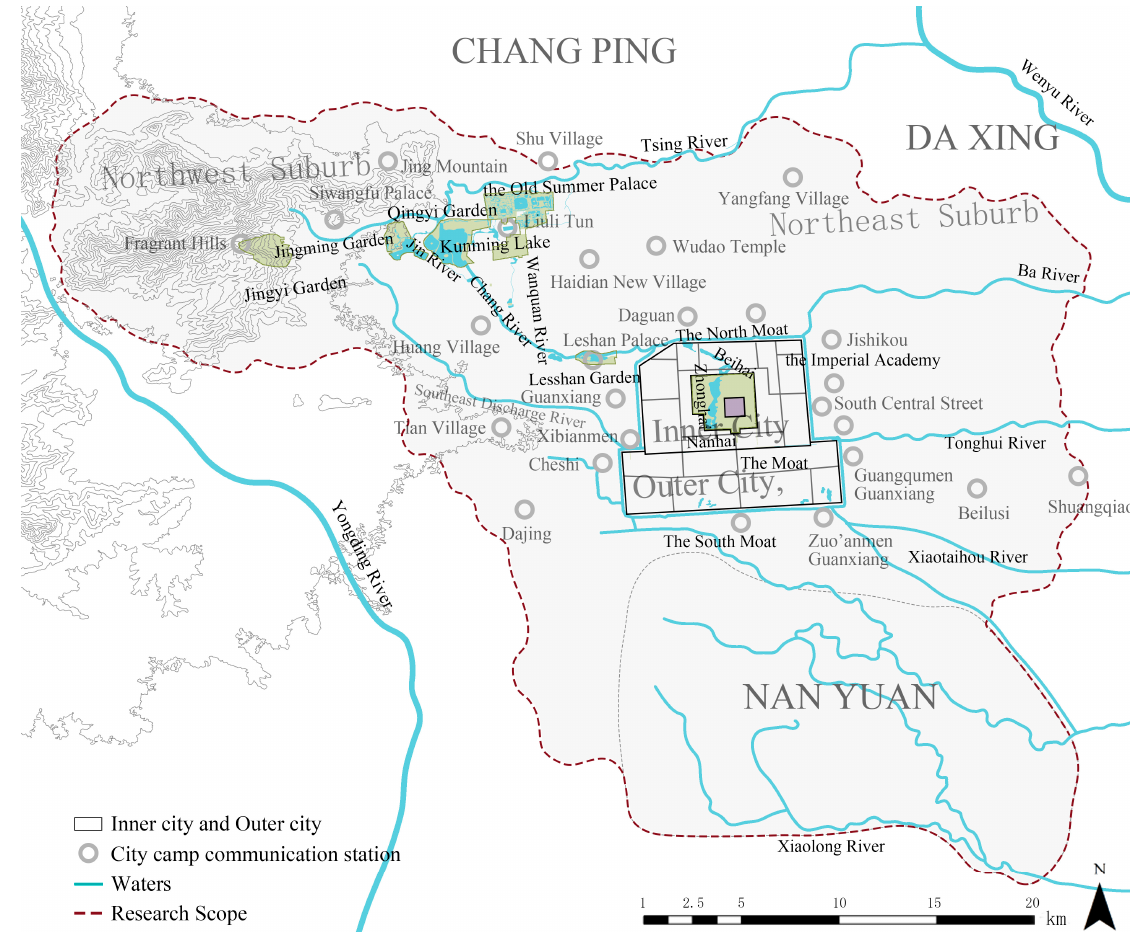
Figure 6. The resulting map after geographic information superposition.